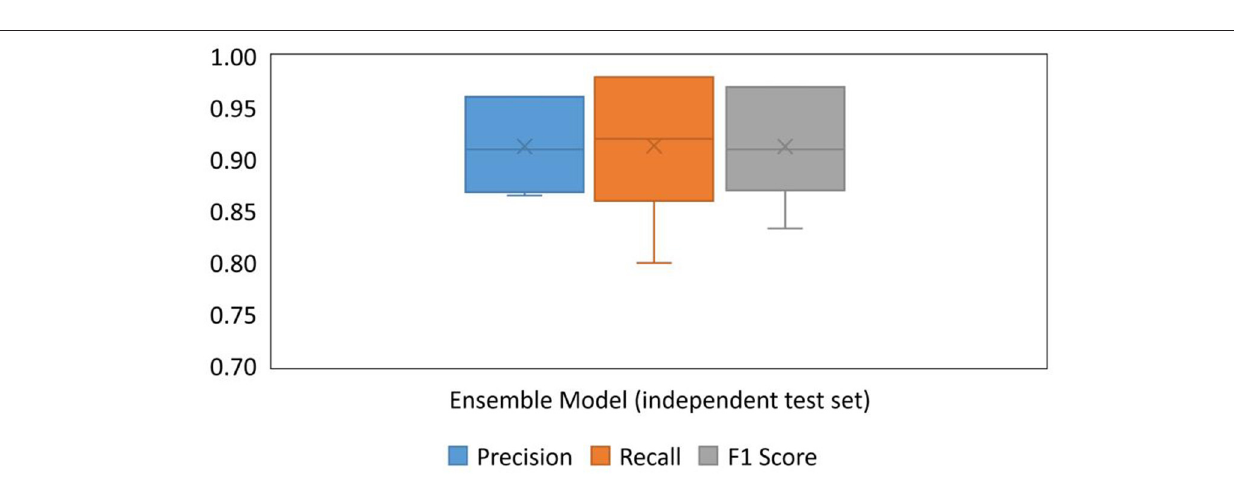
FIGURE 11 | Boxplots of precision, recall, and F1 score for the Ensemble Model, tested with the independent test set of